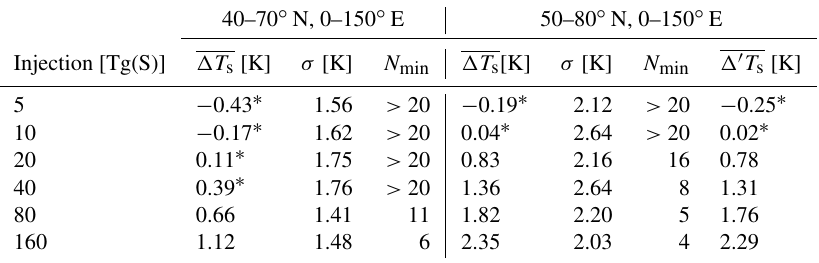
Table 1. Statistics of surface temperature anomalies, averaged over Eurasia, in the first post-eruption winter (DJF) following idealized low- latitude eruptions with injections from 5 to 160Tg(S). Two averaging regions are considered: 40–70 ◦ N, 0–150 ◦ E (as in Polvani et al., 2019; Polvani and Camargo, 2020) and 50–80 ◦ N, 0–150 ◦ E (as in Azoulay et al., 2021). For each averaging region, (cid:49)T s is the ensemble mean anomaly (the response) computed using the difference-from-control-run method, σ the corresponding standard deviation, and N min the minimum ensemble size needed to obtain a response that is statistically significant at the 95% confidence level. Injection amplitudes for which N min > 20 produce responses that are not statistically significant at that level with 20-member ensembles; these insignificant responses are followed by an asterisk. (cid:49) (cid:48) T s is the response computed using the difference-from-reference-period